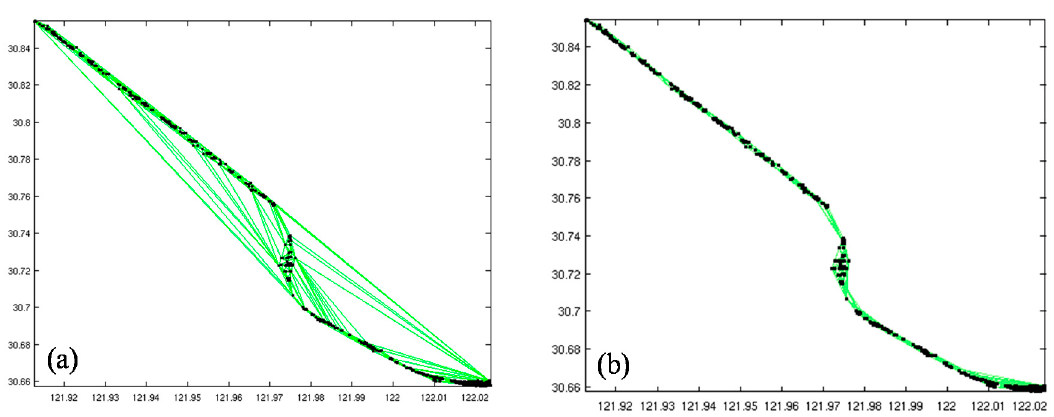
Figure 6. TCP network constructed by ( a ) global Delaunay triangulation and ( b ) local Delaunay triangulation. Black dots and gray lines indicate the temporarily coherent points (TCPs) and the arcs, respectively. The figure is plotted in the World Geodetic System (WGS) 84 coordinate system.